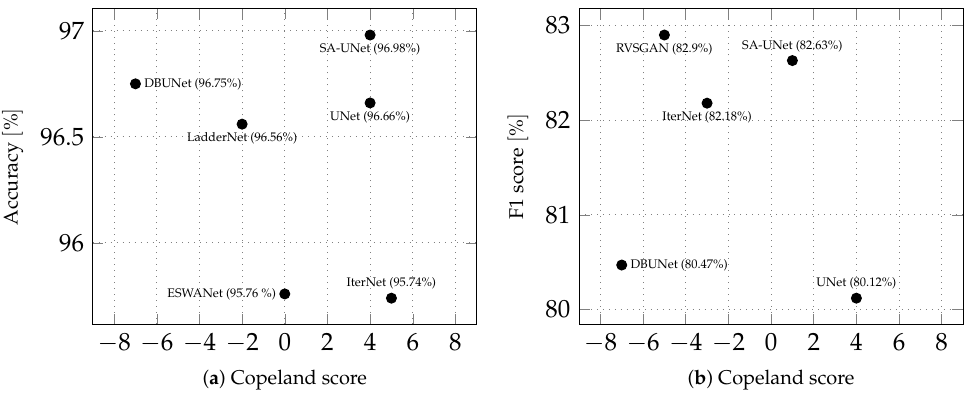
Figure 7. Objective vs. subjective metrics on the DRIVE dataset. The Copeland score is on the x -axes, while the y -axes is ( a ) accuracy (RVSGAN and IterNet_UNI are ommitted since the original paper does not report corresponding accuracy values) and ( b ) F1 score, respectively (LadderNet and IterNet_UNI are omitted since the original paper does not report corresponding accuracy values). Each dot on a diagram corresponds to one of the CNNs with an associated Copeland score and objective metric value. The accuracy and F1 score values for RSVGAN, ESWANet, SA-UNet, and IterNet are from the original papers. Values for DBUNet are from supplementary materials of the project used in [37]. The results for UNet are from [31] since UNet was not evaluated on the DRIVE dataset in the original